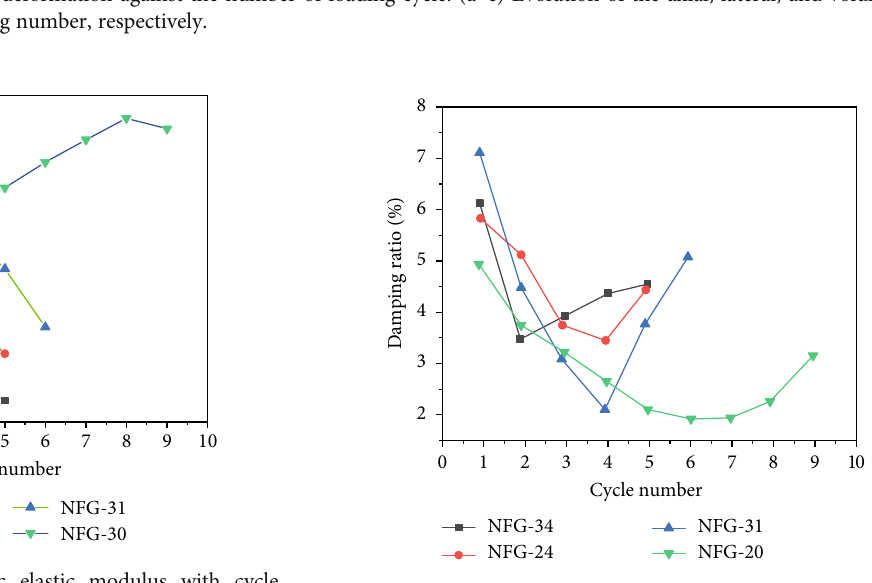
Figure 13: Evolution of dampling ratio with cycle